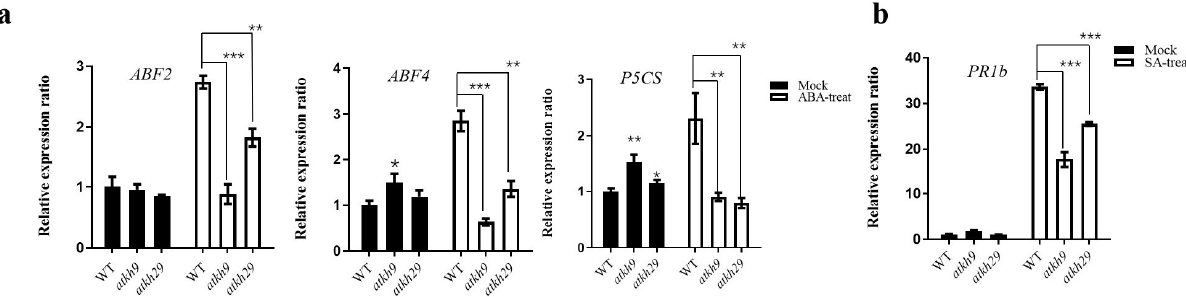
Figure 9. The expression of ABA and SA related genes of the wild type, atkh9 and atkh29 mutants under ABA and SA treatments for 10 d. ( a ) The expression of ABA-related genes ABF2 , ABF4 , and P5CS . ( b ) The expression of SA-related gene PR1b . The histogram indicated the average value of the experiment with three replicates. Error bars indicated SD. p value (* p < 0.05, ** p < 0.01, *** p < 0.001) was calculated using one-way analysis of variance and Tukey’s test for statistics.